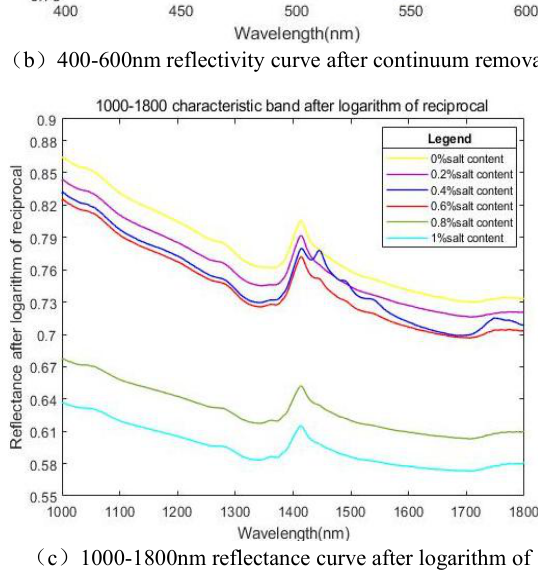
（ b ） 400-600nm reflectivity curve after continuum removal